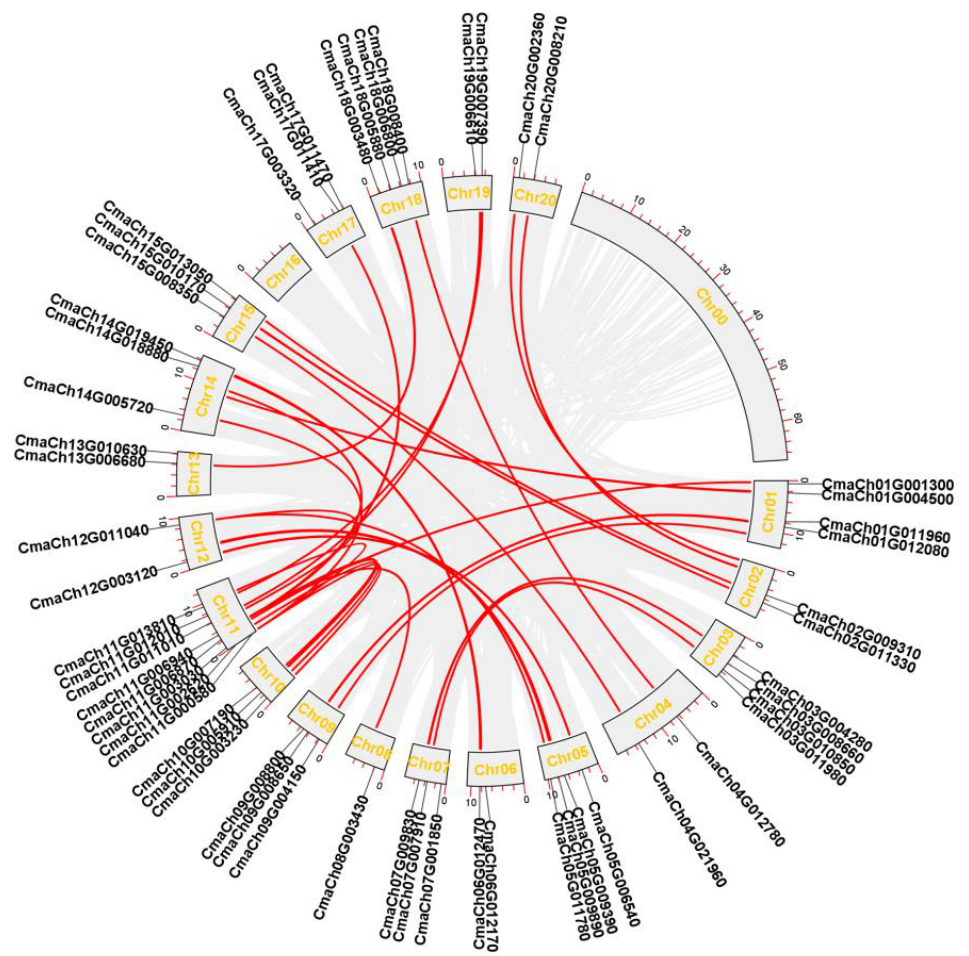
paralogs between C. maxima and C. sativus (Figure 4). Thus, in the WD40 gene family, the relationship between C. maxima and A. thaliana is slightly closer.